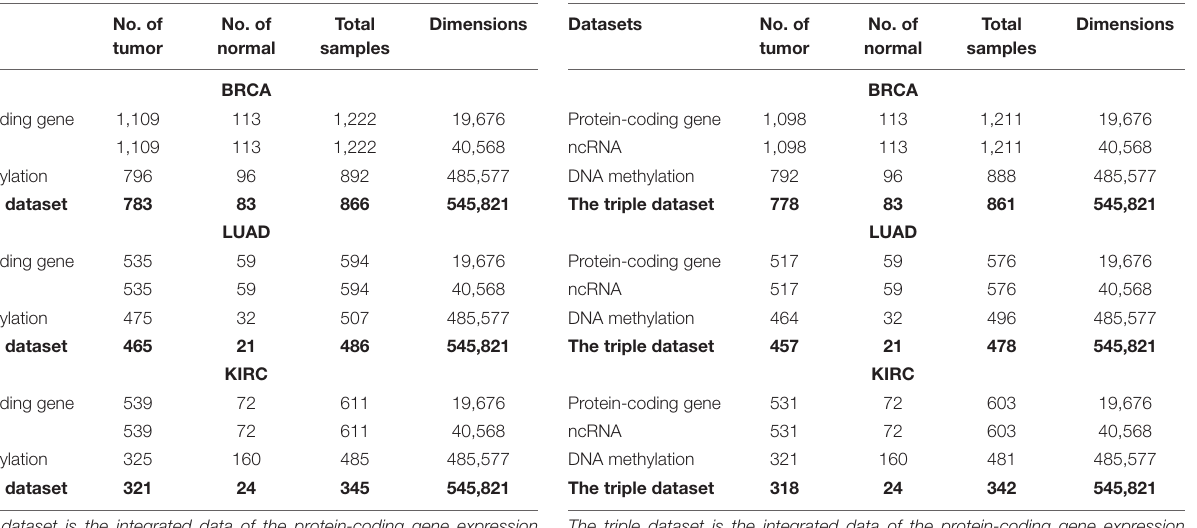
TABLE 2 | Summary of preprocessed datasets for three